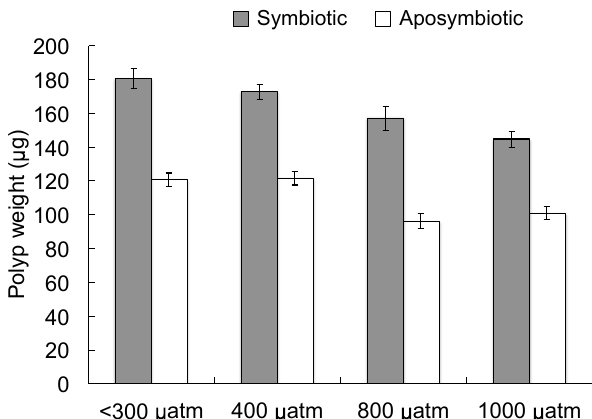
Fig. 1. Skeletal weights of primary polyps of Acropora digitifera in the (i) pre-industrial p CO 2 , <300µatm, (ii) present-day p CO 2 at 400µatm, and at two near-future conditions of (iii) 800µatm, and (iv) 1000µatm. Bars show